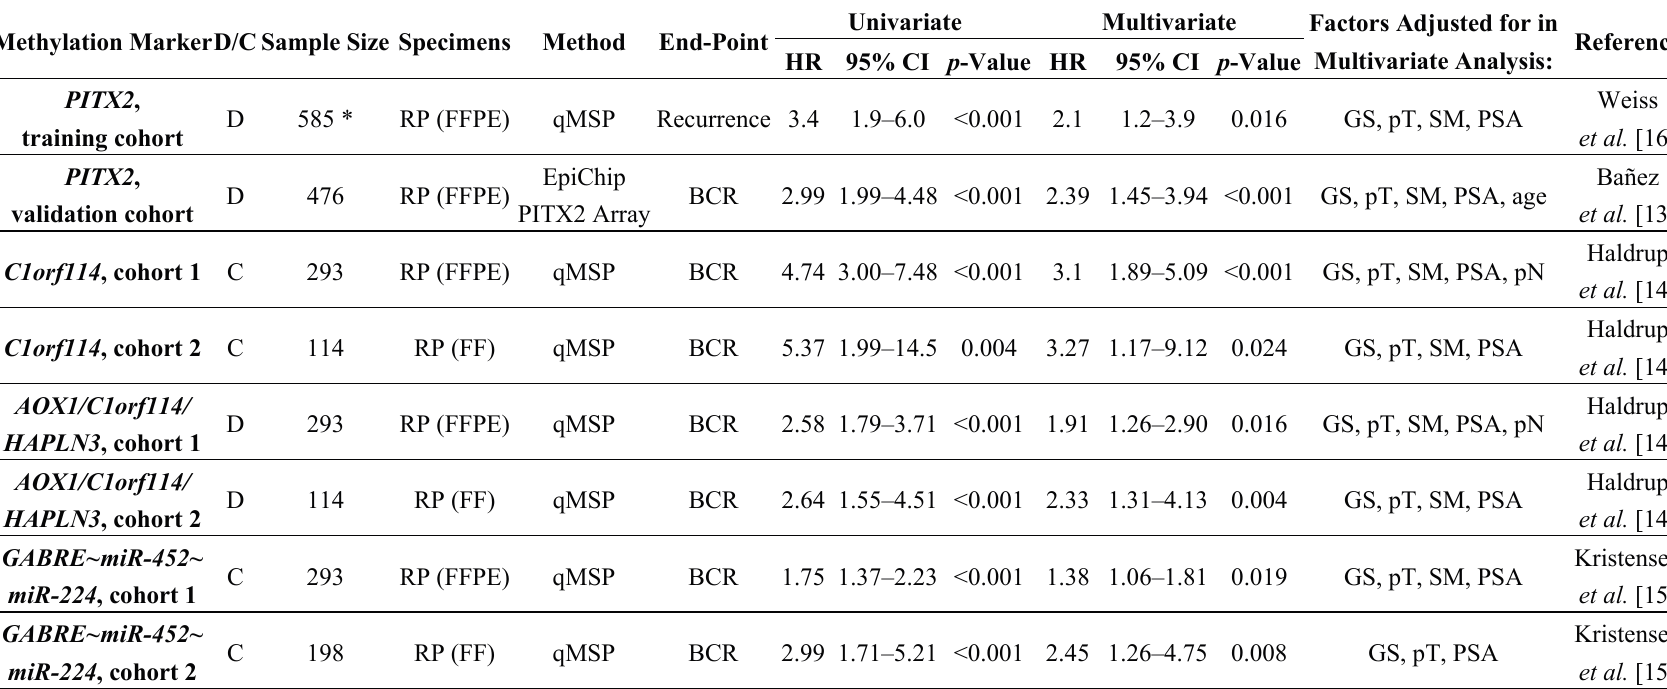
* Accurate Gleason score information missing for 239 of these